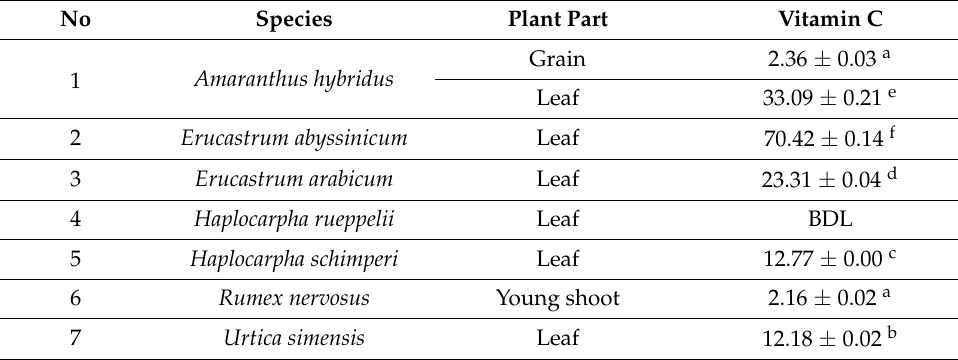
Table 4. Vitamin C (Ascorbic acid) contents of selected WEPs (mg/100 g DW). No Species Plant Part Vitamin